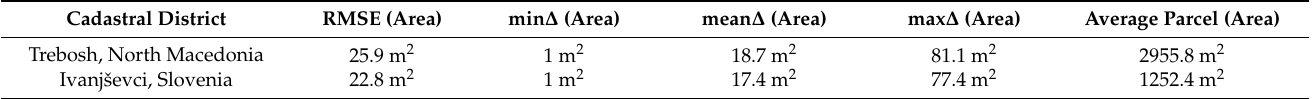
Table 2. Differences of land parcel areas—documentary boundaries compared to digital spatial